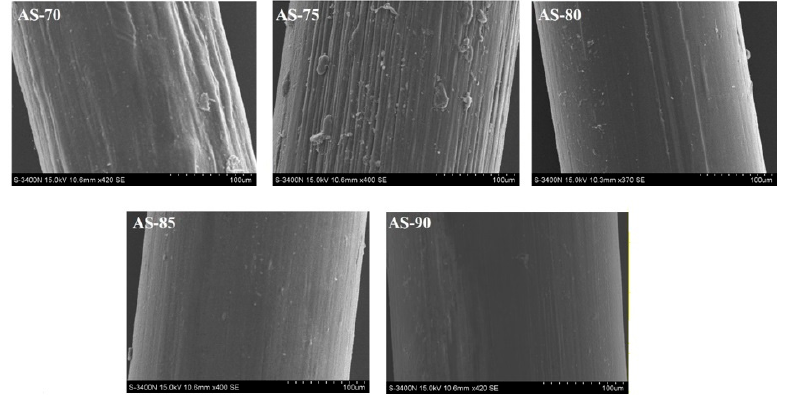
Figure 4. Effects of chitosan’s DD on residual ratio ( a ) and BSR ( b ) of its monofilament with enzy- matic hydrolysis.